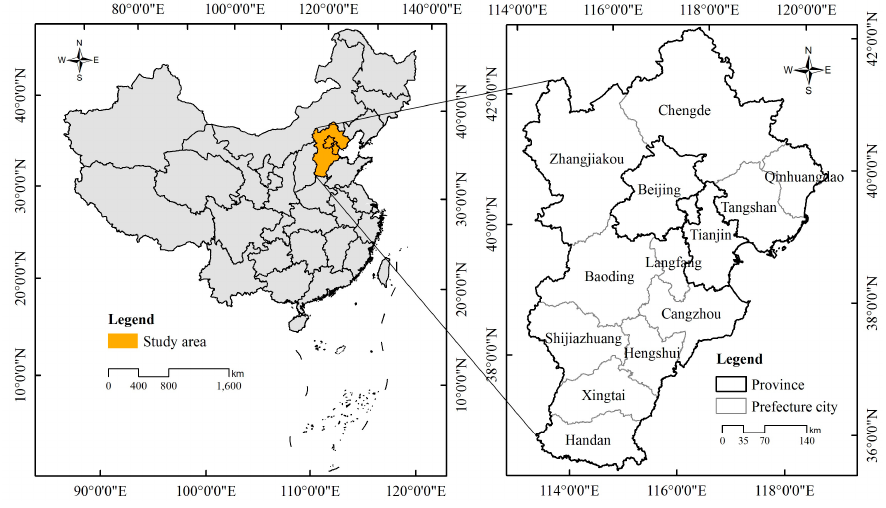
Figure 1. Location of study area.